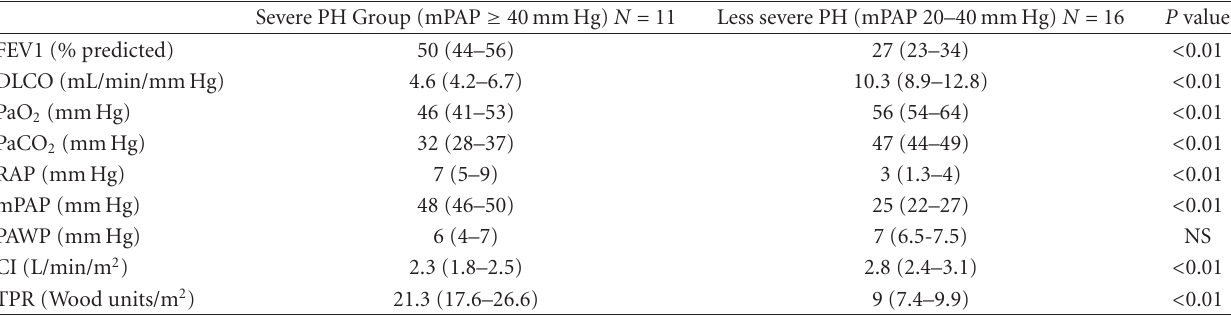
Table 2: Comparison of 2 groups of COPD patients with PH.